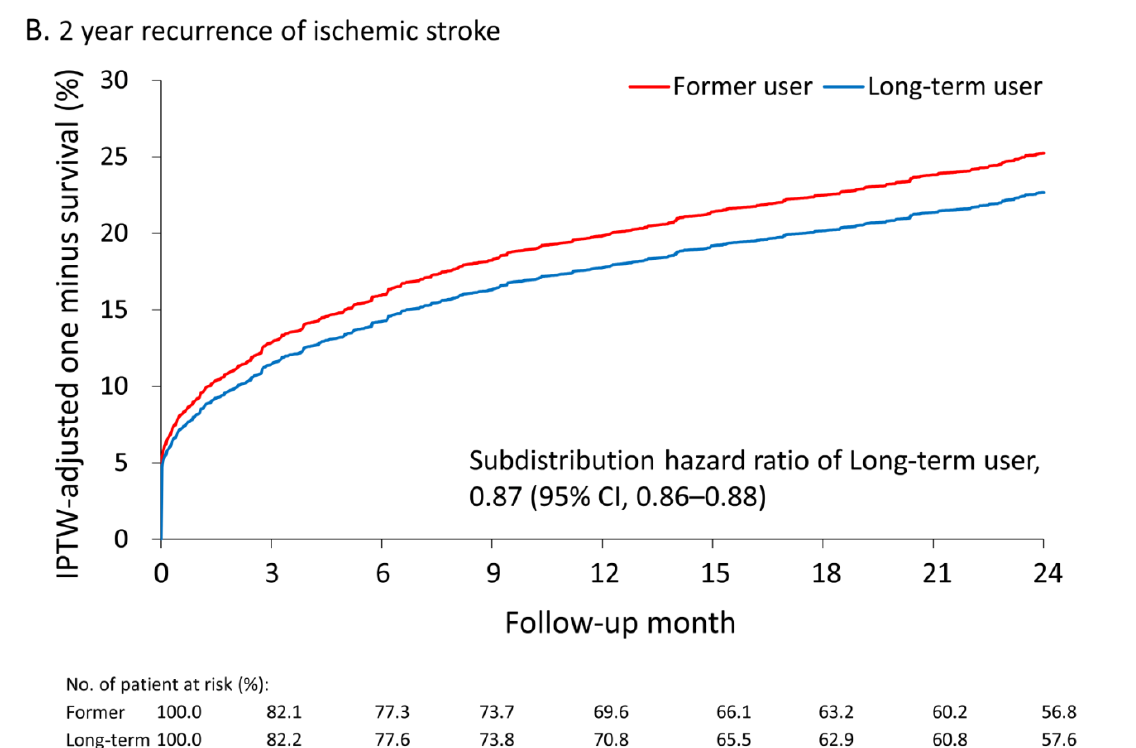
Figure 2. The cumulative incidence of recurrent ischemic stroke during the 2-year follow-up between new colchicine users and non-users ( A ) and between long-term colchicine users and former colchicine users ( B ) in the cohort after IPTW. IPTW, inverse probability of treatment weights.